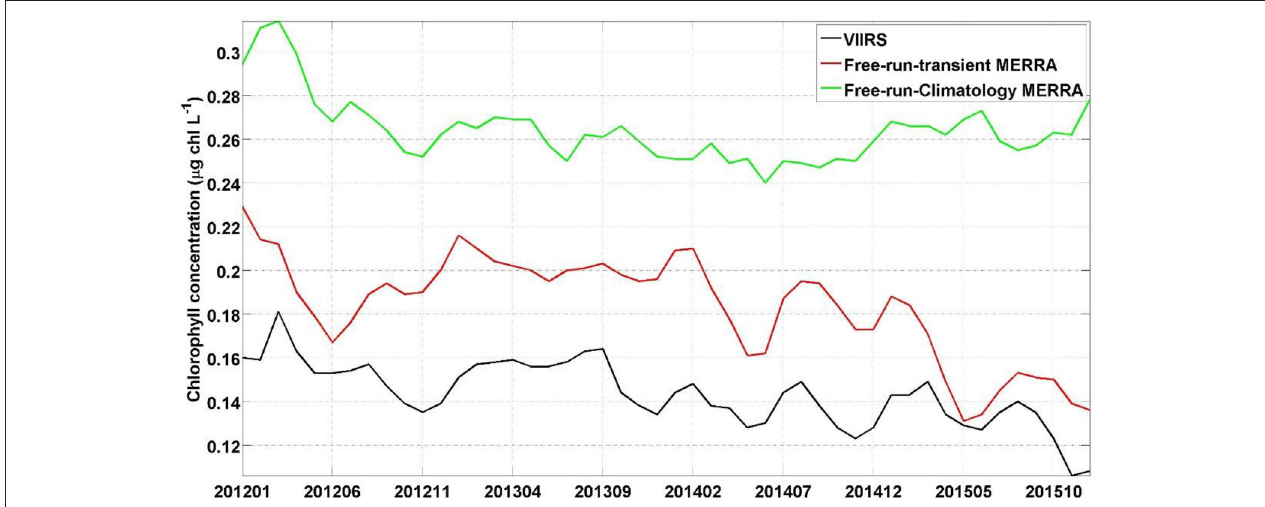
FIGURE 3 | Time series of chlorophyll concentration ( µ g chl L − 1 ) for NPP-VIIRS (black), free-run model with transient MERRA forcing data (red) and free-run model with a climatological MERRA forcing data (green).